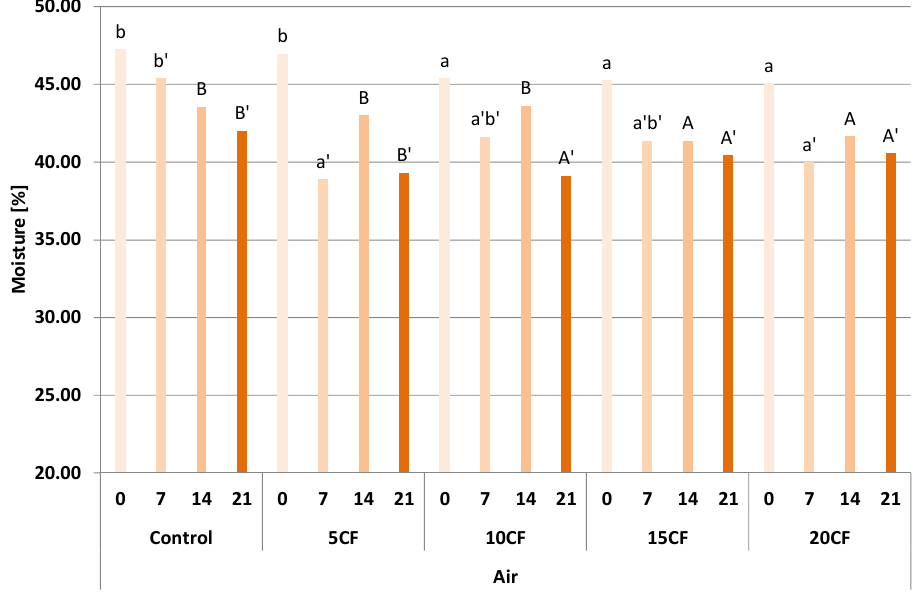
Figure 1. Moisture of the crumb of gluten-free breads with the addition of chestnut flour in the amount of 5% (5CF), 10% (10CF), 15% (15CF) and 20% (20CF) after 7, 14 and 21 days of storage, packed in a barrier film with air. Values marked with the same symbols mean no statistically significant differences (α = 0.05).